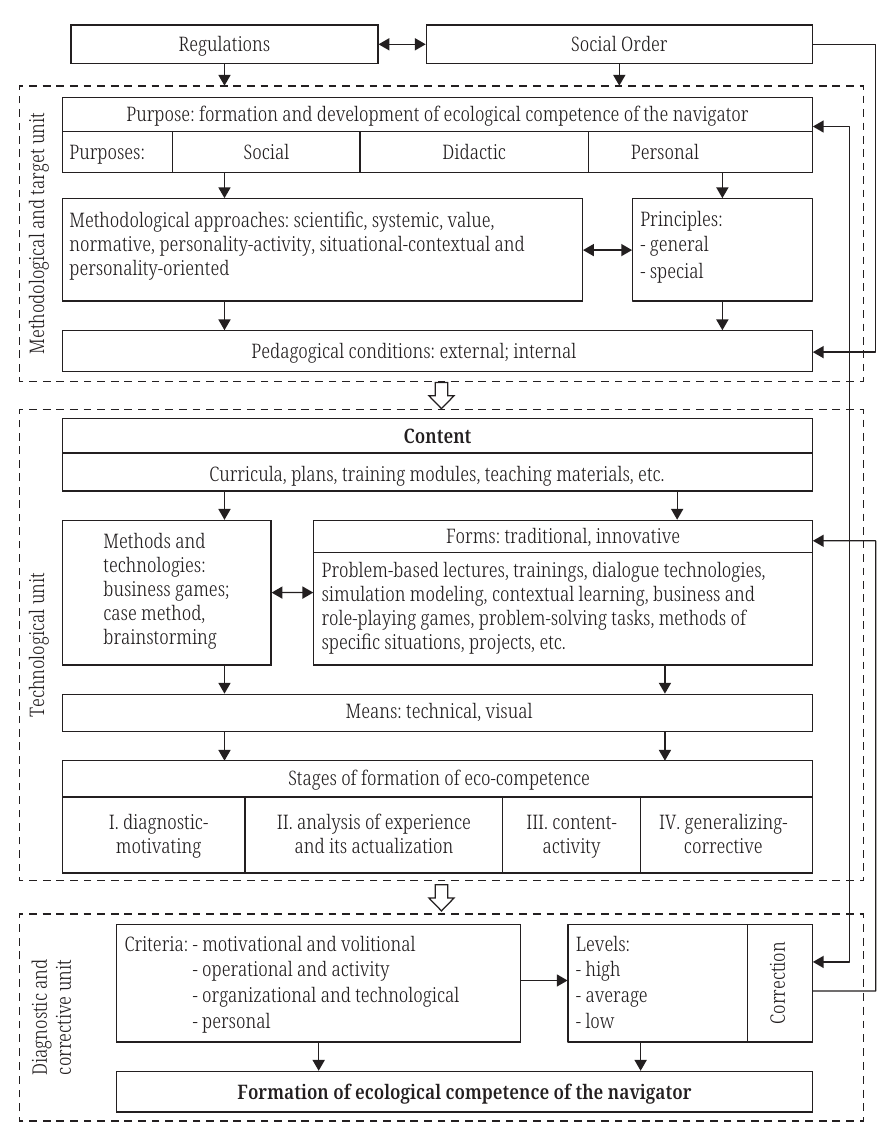
Fig. 1. Model of formation of ecological competence of